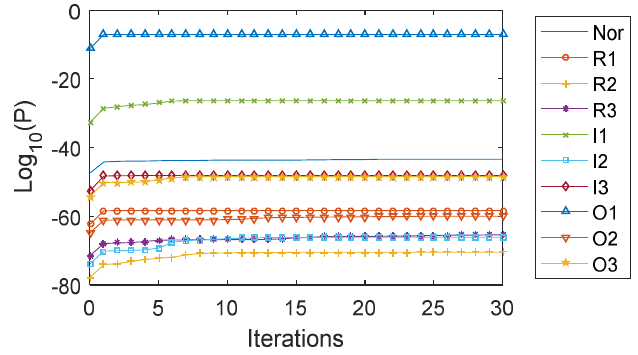
Fig. 3 Training curves of various fault states of HMMs.